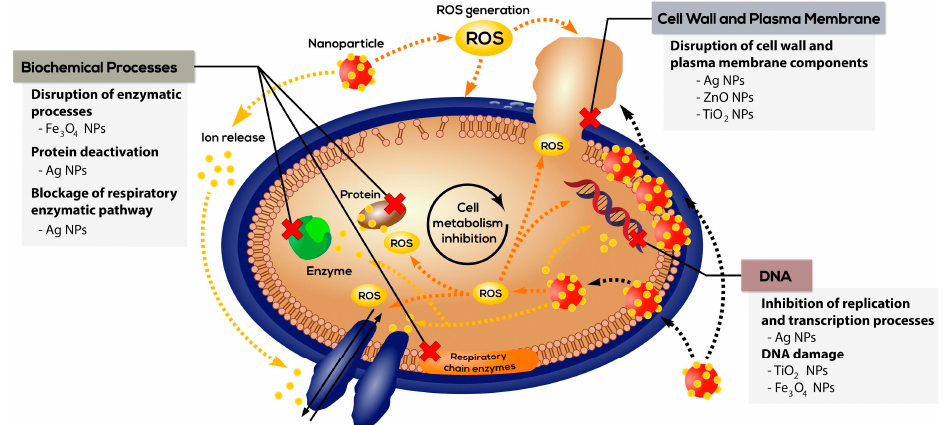
Figure 6. Various targets in the bacteria are available for nanoparticles, particularly silver nanoparticles. Reprinted with permission from [68]. Copyright 2022, Elsevier.